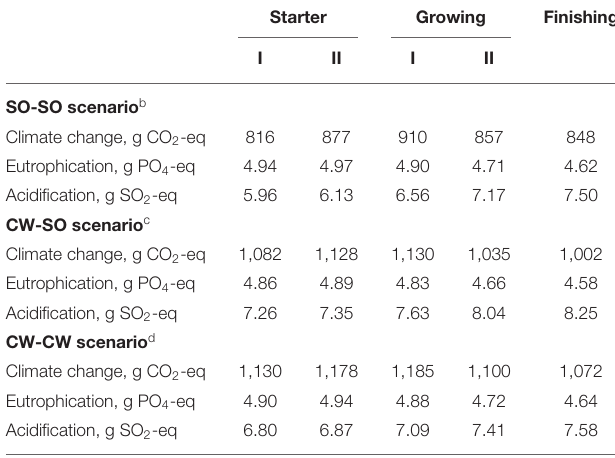
TABLE 7 | Potential environmental impacts of control feeds a (1kg at feed mill gate, formulated without β -mannanase) for broilers in different grain production scenarios. Starter